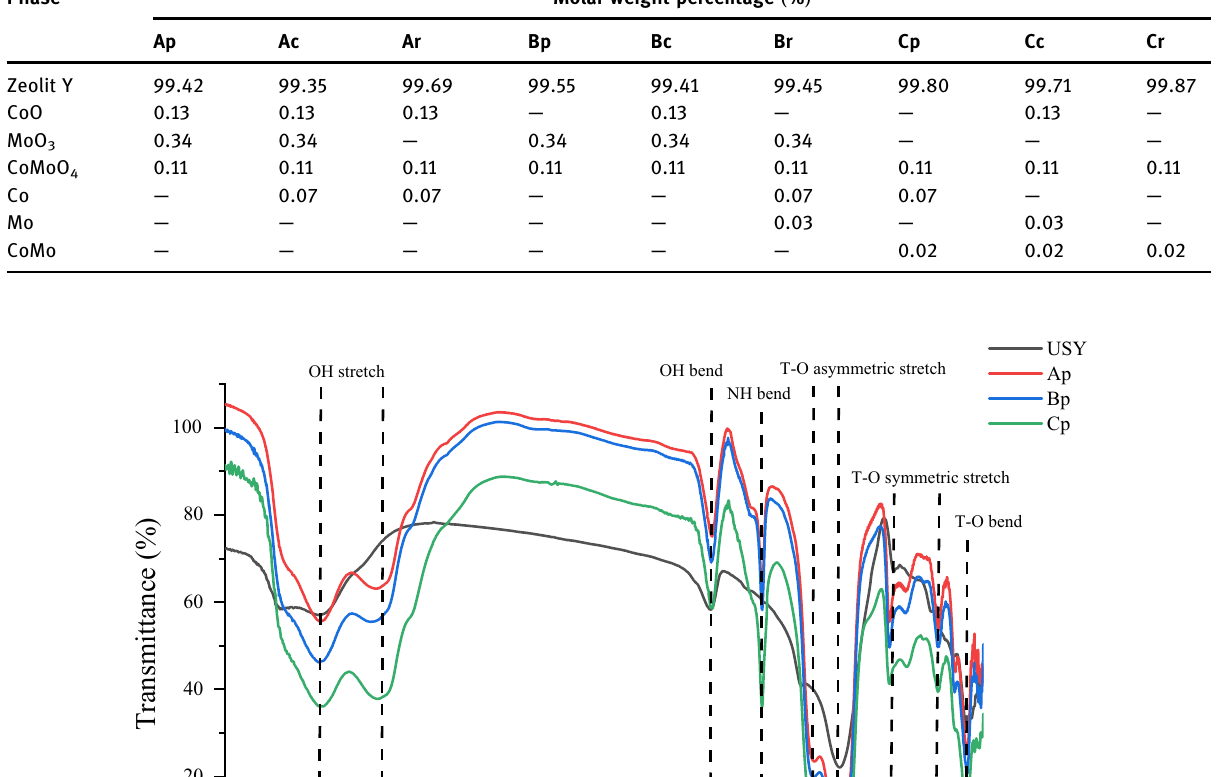
Table 1: Particle molar weight percentage data on the catalyst Phase